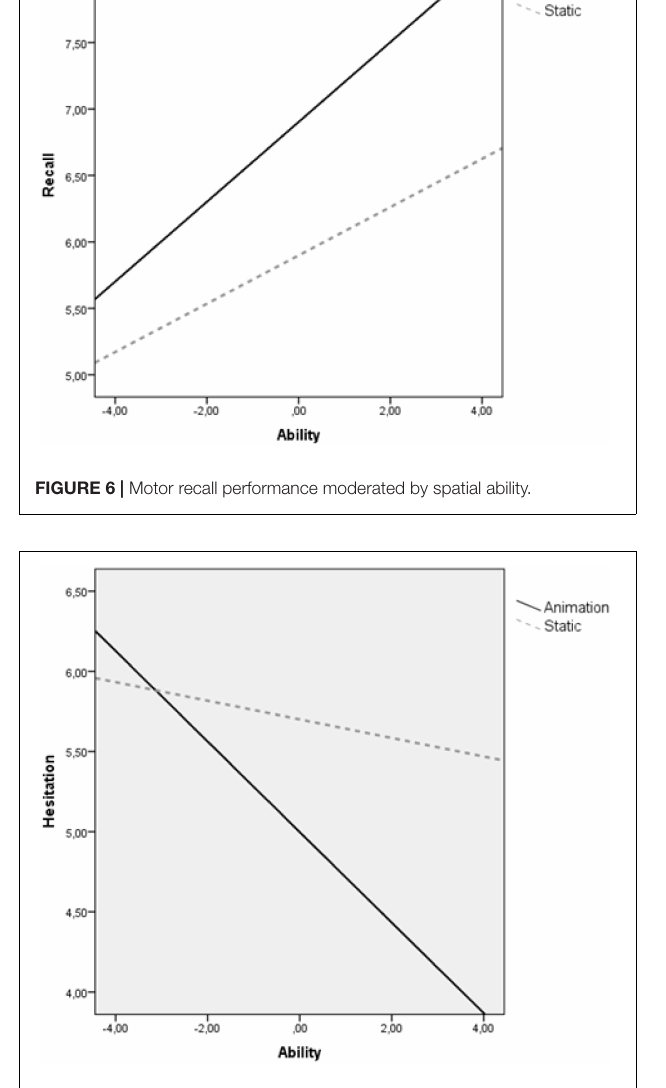
FIGURE 7 | Hesitation time moderated by spatial